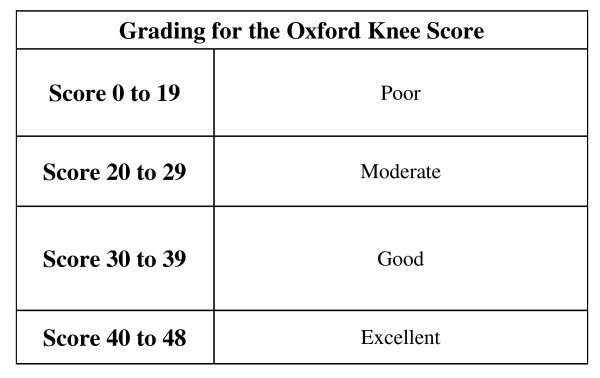
Oxford knee score.